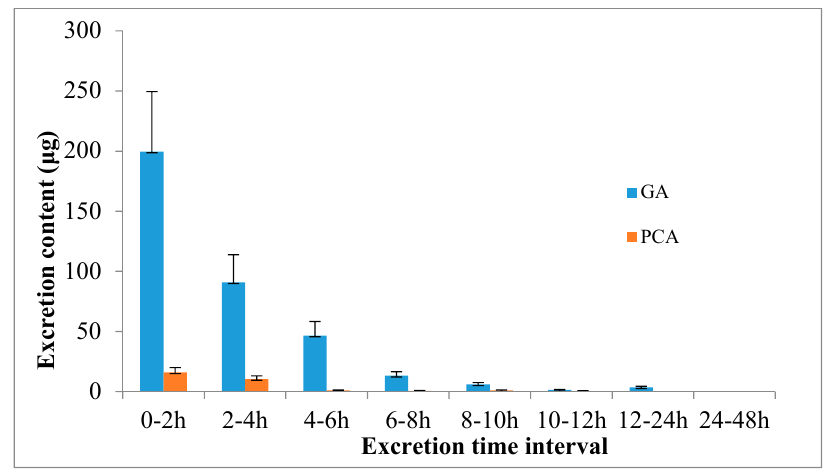
Figure 4. Excretion profiles of GA and PCA in rat after oral administration of 60 mg/kg P. capitatum